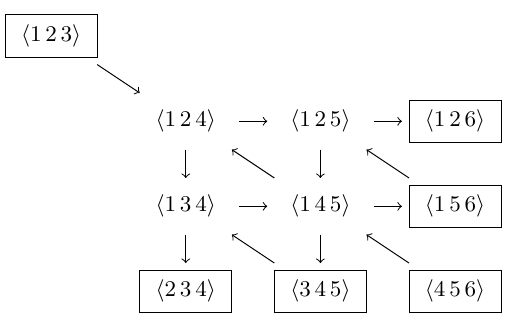
Figure 2. The initial cluster of the Grassmannian cluster algebra Gr(3 , 6)